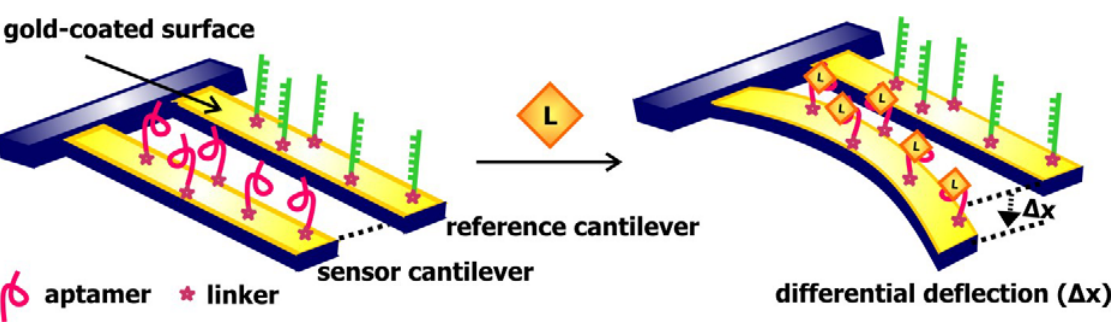
Figure 9. Design and mechanism of cantilever-based aptamer biosensors by Savran and colleagues [62]. Using this system, ligand concentration may be assessed by measuring the extent of deflection of the sensor